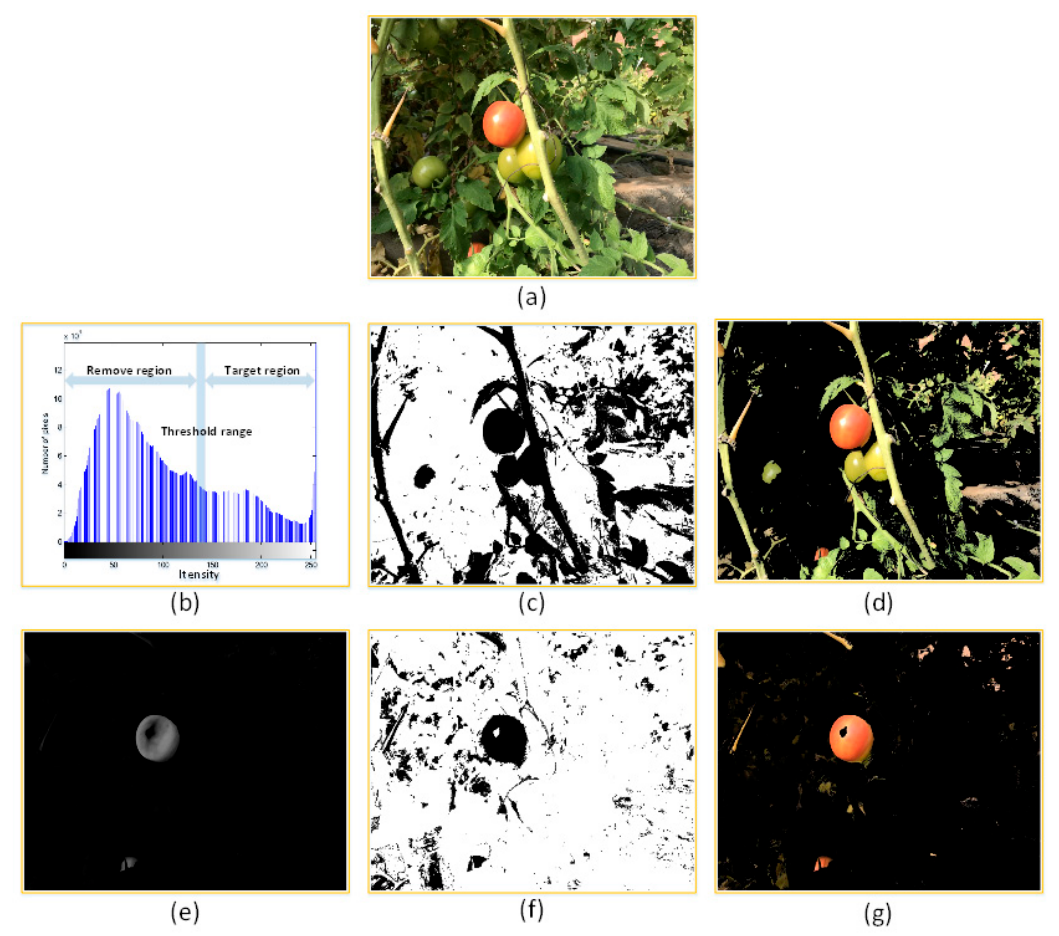
Figure 6. Results and comparison, for the cases in which only the R component was used and the integrated colour parameter. ( a ) Example image of ripening tomatoes. ( b ) Histogram of the image’s red component. ( c ) Segmentation mask image (Component R only). ( d ) Performance of the algorithm that uses only the R component. ( e ) Black-and-white image obtained using the integrated colour parameter method. ( f ) Segmentation mask image (Components R, G, B were used). ( g ) Result obtained using the integrated colour parameter method.